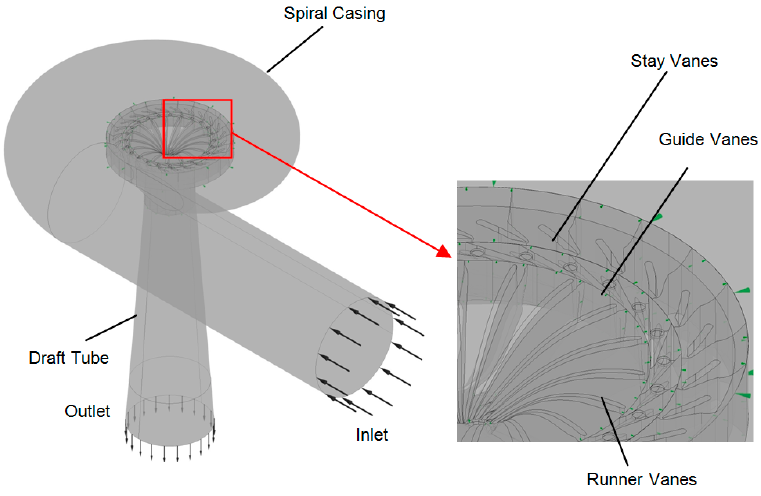
Figure 6. Computational domain.